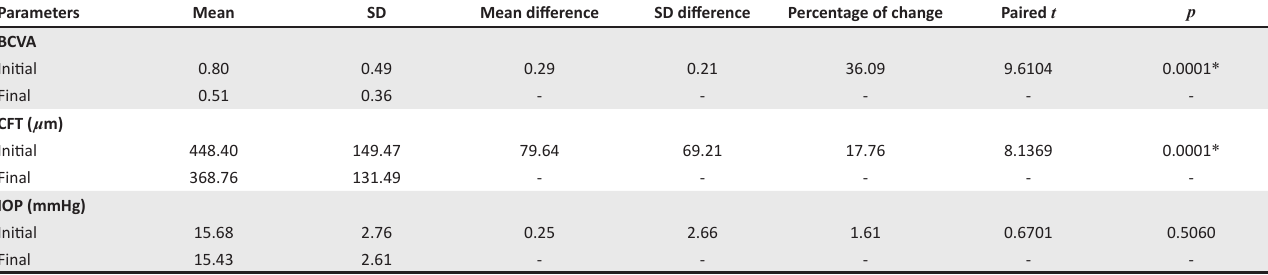
TABLE 2: Comparison of initial and final best corrected visual acuity, central foveal thickness and intraocular pressure by dependent t -tests.